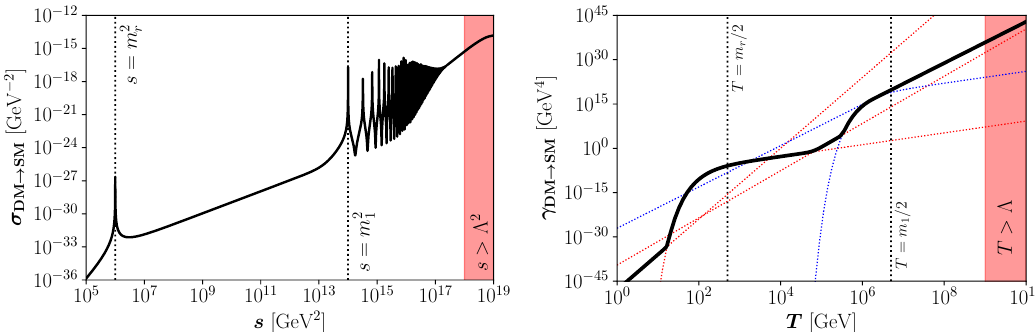
Figure 1 . Black solid lines represent the DM annihilation cross section (left panel) and interaction rate density (right panel) for m r = 10 3 GeV, m 1 = 10 7 GeV and (cid:3) = 10 9 GeV. Colored lines depict the analytical approximations of eq. (3.13), where red and blue stand for interactions dominated by the exchange of a radion or a KK-gravitons, respectively. The red-shaded regions on the right of both panels are beyond our EFT